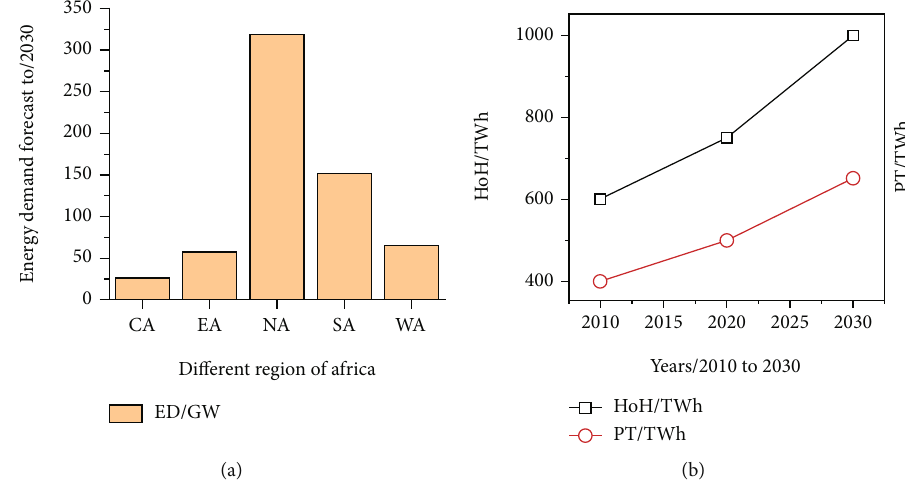
Figure 5: (a) Di ff erent regions of Africa. CA: central Africa; EA: east Africa; NA: north Africa; SA: southern Africa; WA: west Africa. (b) Household (HoH) and productive and transport (PT) sector energy demand.